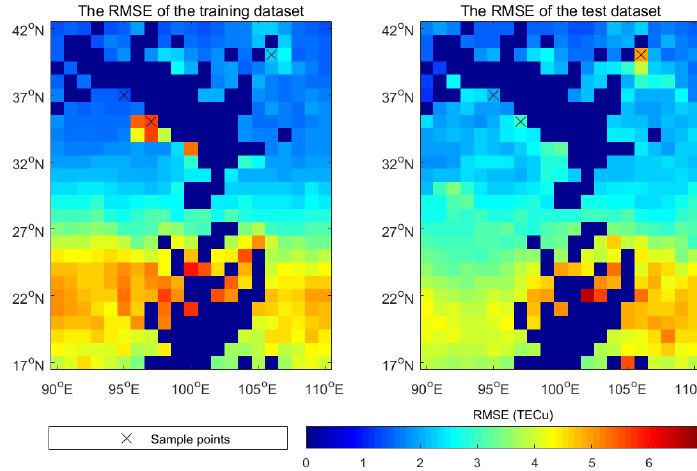
Figure 7. The RMSE of the training and test dataset.